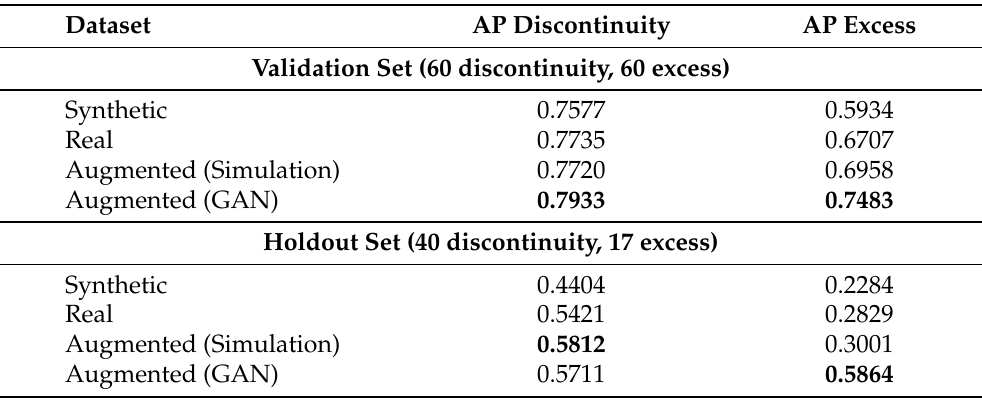
Table 2. Average Precision (AP) per defect class with an IoU threshold of 50%, validated first on a set of 58 real images, then on a holdout set of 19 real images. The number of instances of each defect is listed in the